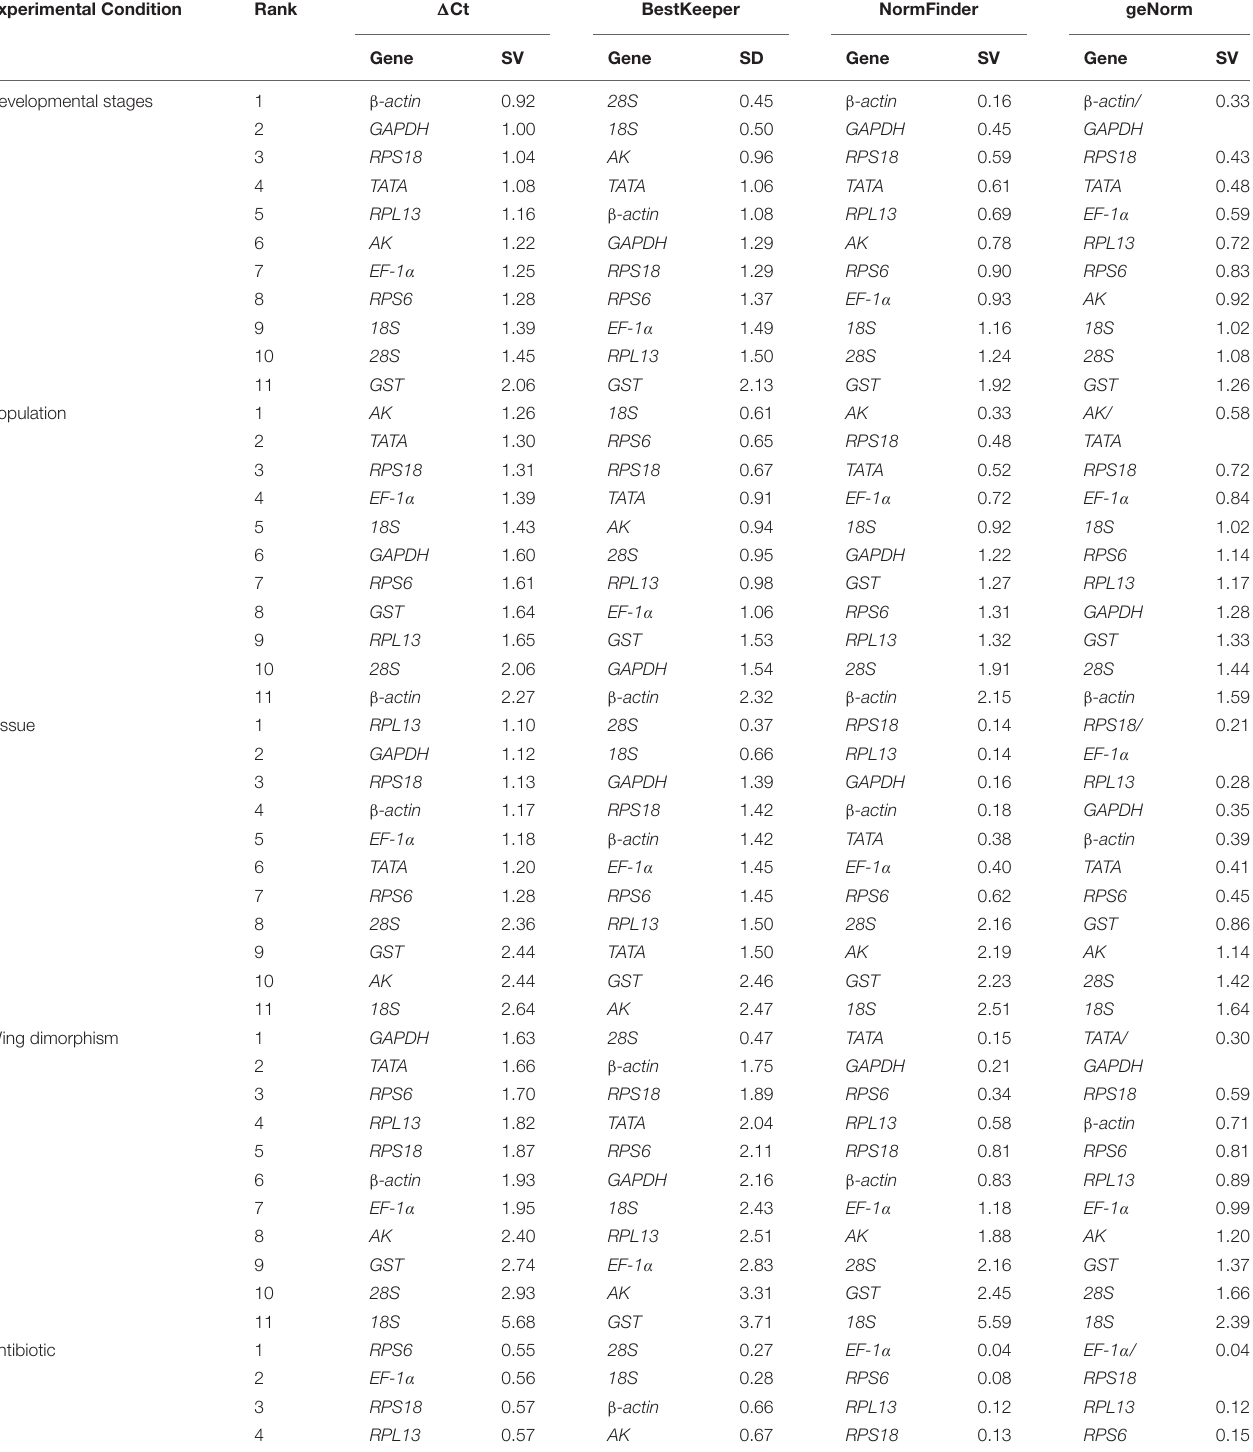
TABLE 2 | Rank order of the R. padi candidate reference genes under various experimental conditions. Experimental Condition Rank (cid:49) Ct BestKeeper NormFinder geNorm Gene SV Gene SD Gene SV Gene SV Developmental stages